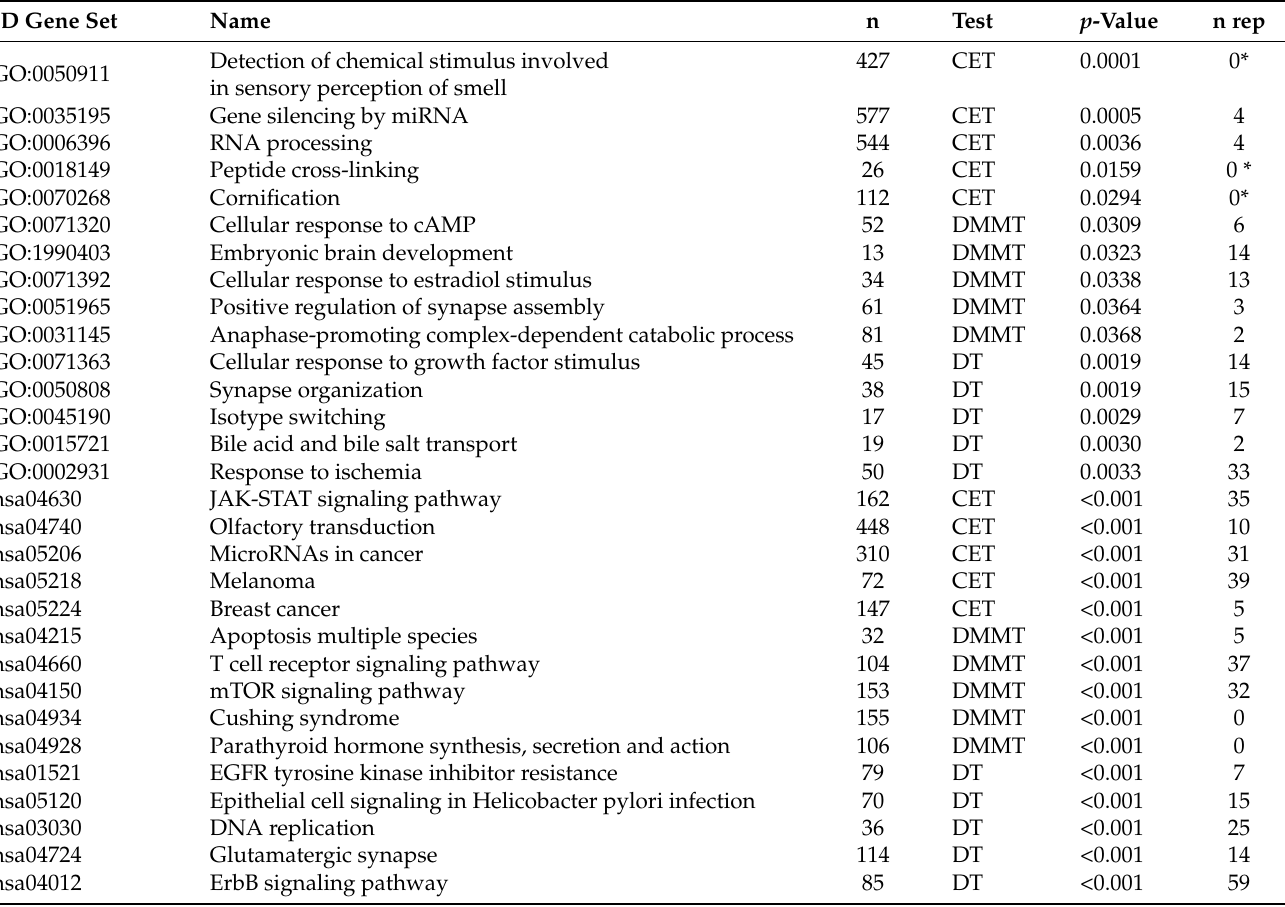
Table 2. List of the top five gene sets reported by each statistic test using the complete distribution: CET, DMMT, and DT. The “n” column refers to genes in the set. The number of papers (n rep) reporting the gene set association with Colorectal Neoplasms obtained from the Comparative Toxicogenomics Database (GO terms) and MEDLINE bibliographic database (KEGG ID AND “colorectal cancer”). The * indicates that the gene set was related to other cancer